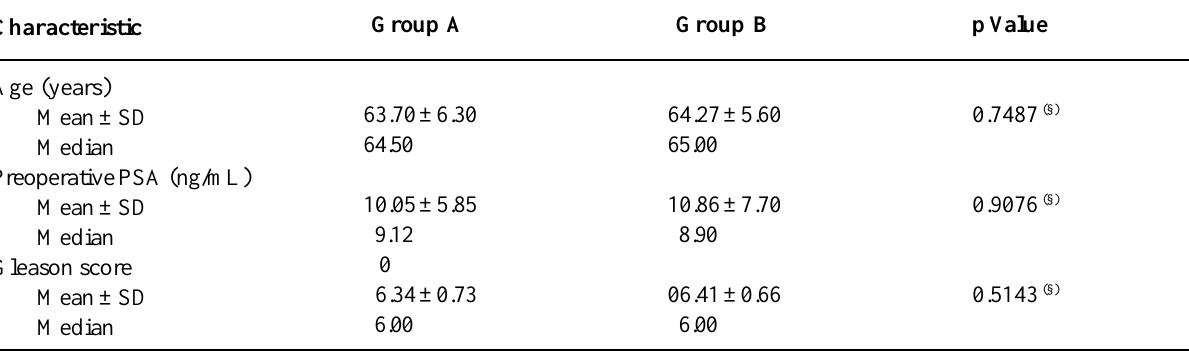
Table 3 – Clinicopathologic features of 172 patients with prostate cancer in the biopsy by groups A (with atrophy and no inflammation) and B (inflammatory